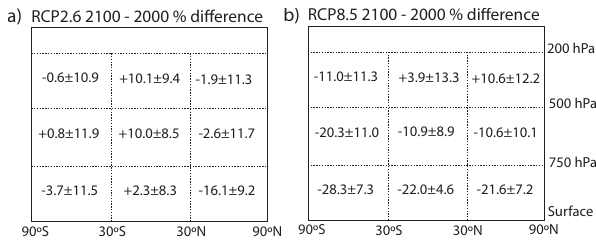
Fig. 7. Changes in regional mean OH concentration between 2100 and 2000 in various tropospheric subdomains. The range represents inter-model ± 1 σ spread of the change.